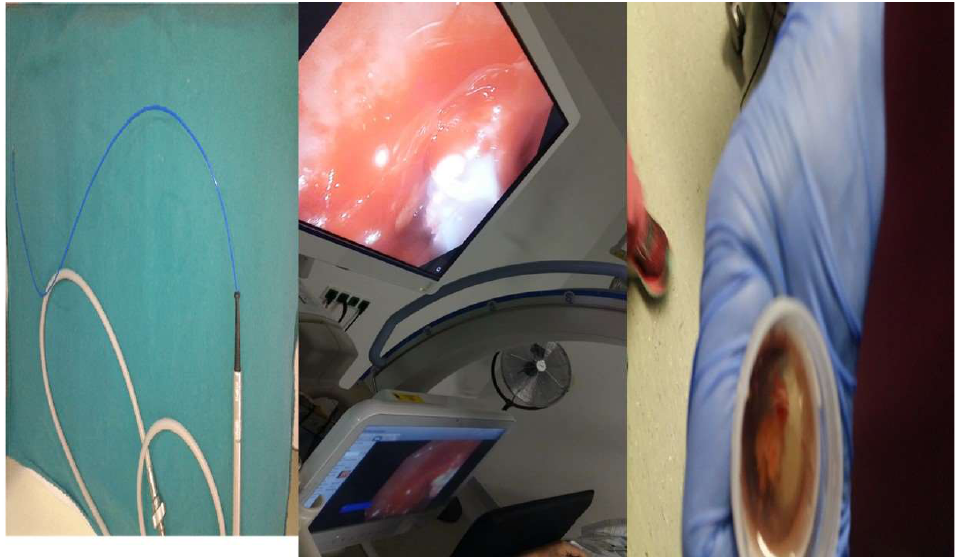
Figure 2. Left: ERBE 1.1 mm cryoprobe; middle: image during the biopsy; and right: sample speci- men.